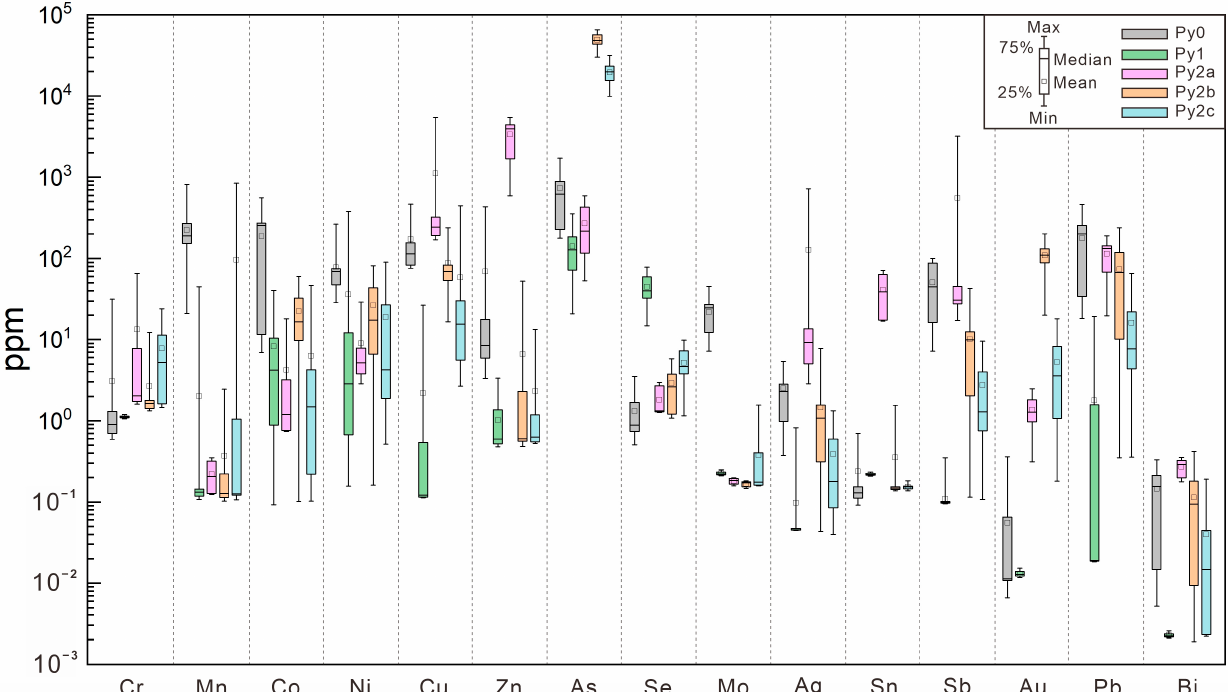
Figure 8. Boxplot showing selected trace element contents in different types of pyrite from the Dunbasitao gold deposit.